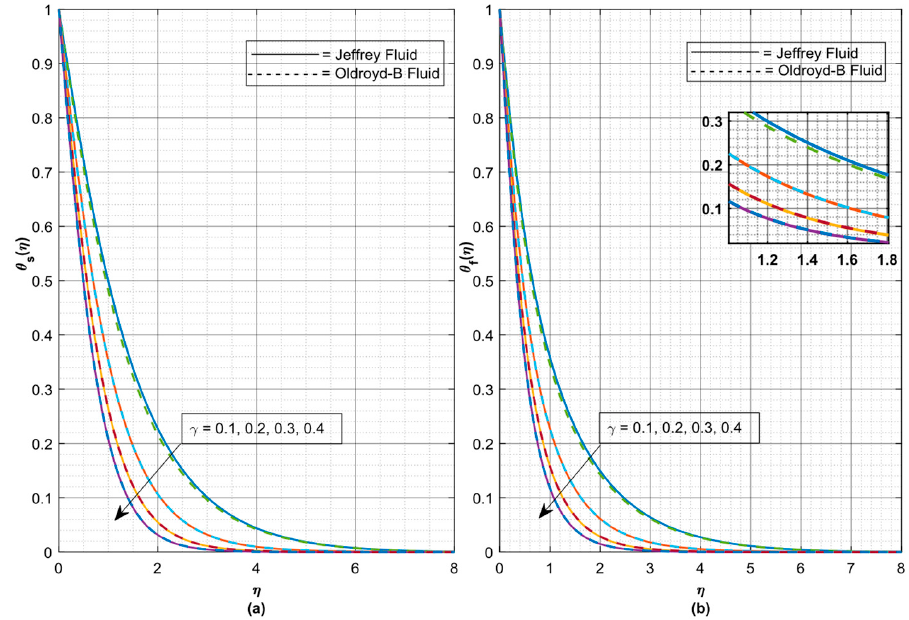
( ) γ θ η on , and ( b ) effect of f